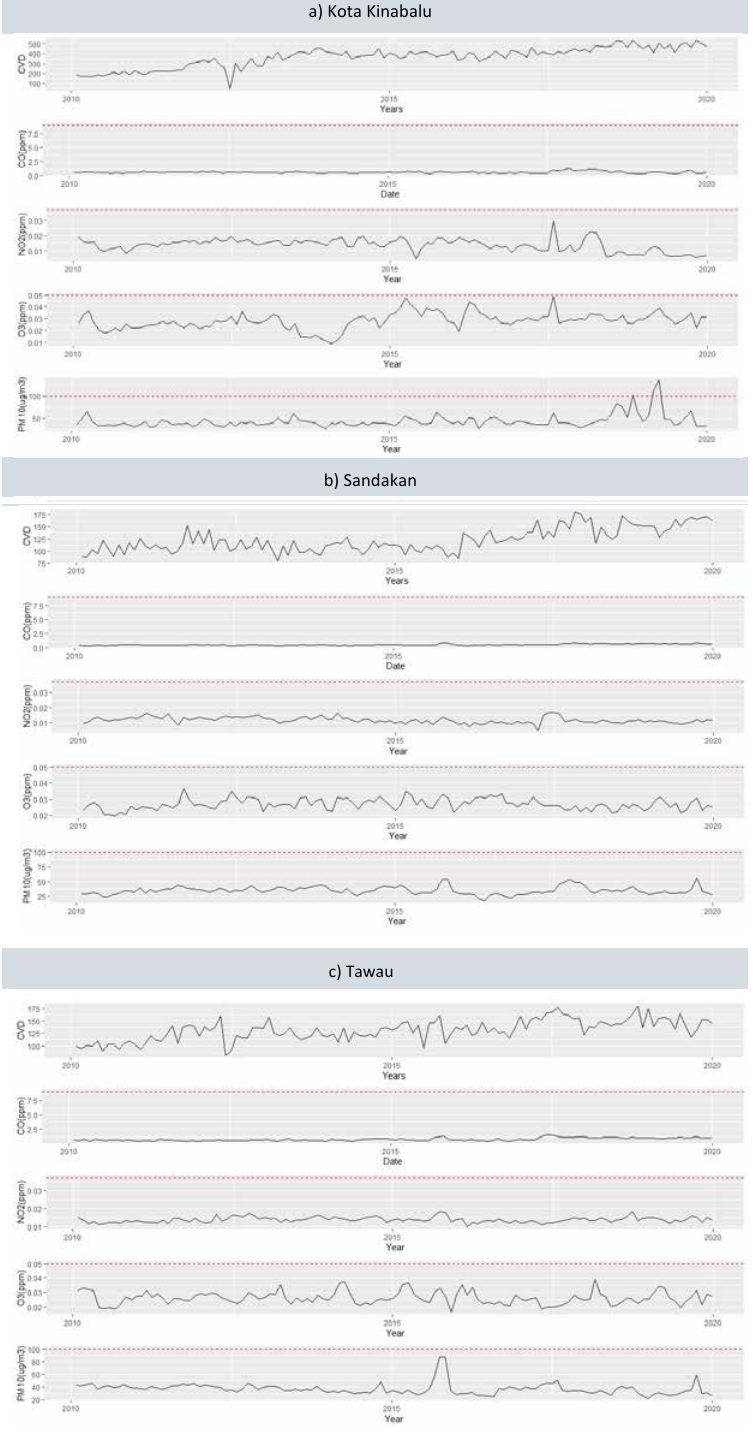
Fig. 1: Time series analysis of hospital admission for cardiovascular and air pollutants in Kota Kinabalu